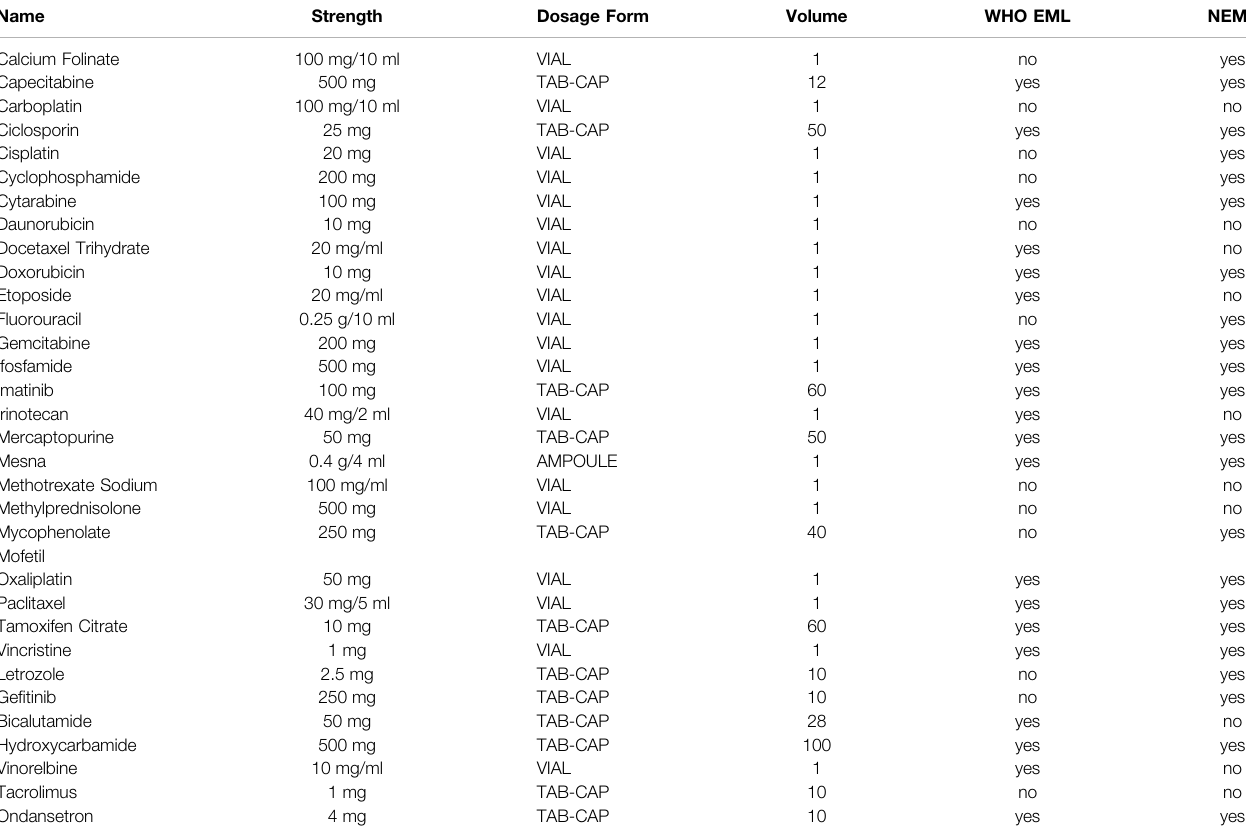
TABLE 1 | List of 32 anticancer medicines surveyed in the Hubei Province.